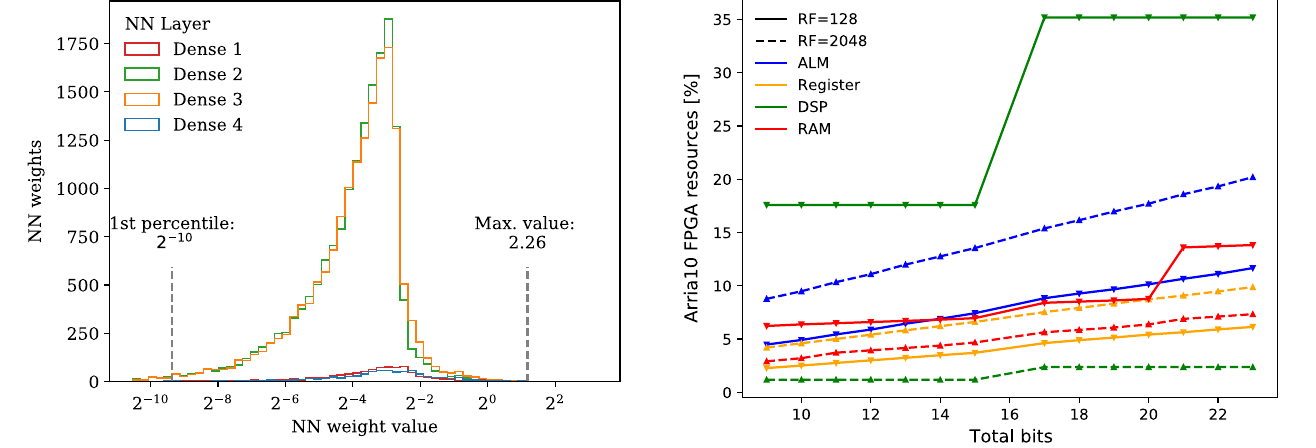
FIG. 8. Separate histograms display the magnitude of the floating-point weights obtained for each many-to-many ( “ dense ” ) layer after training the DQN MLP, in bins of logarithmically varying width. Over 99% of weights are found to have absolute value greater than 1 = 2 10 , with a maximum value of 2.26.